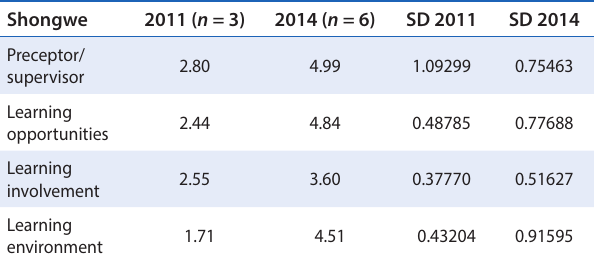
Table 1: Outcomes of the MedIQ instrument in Shongwe